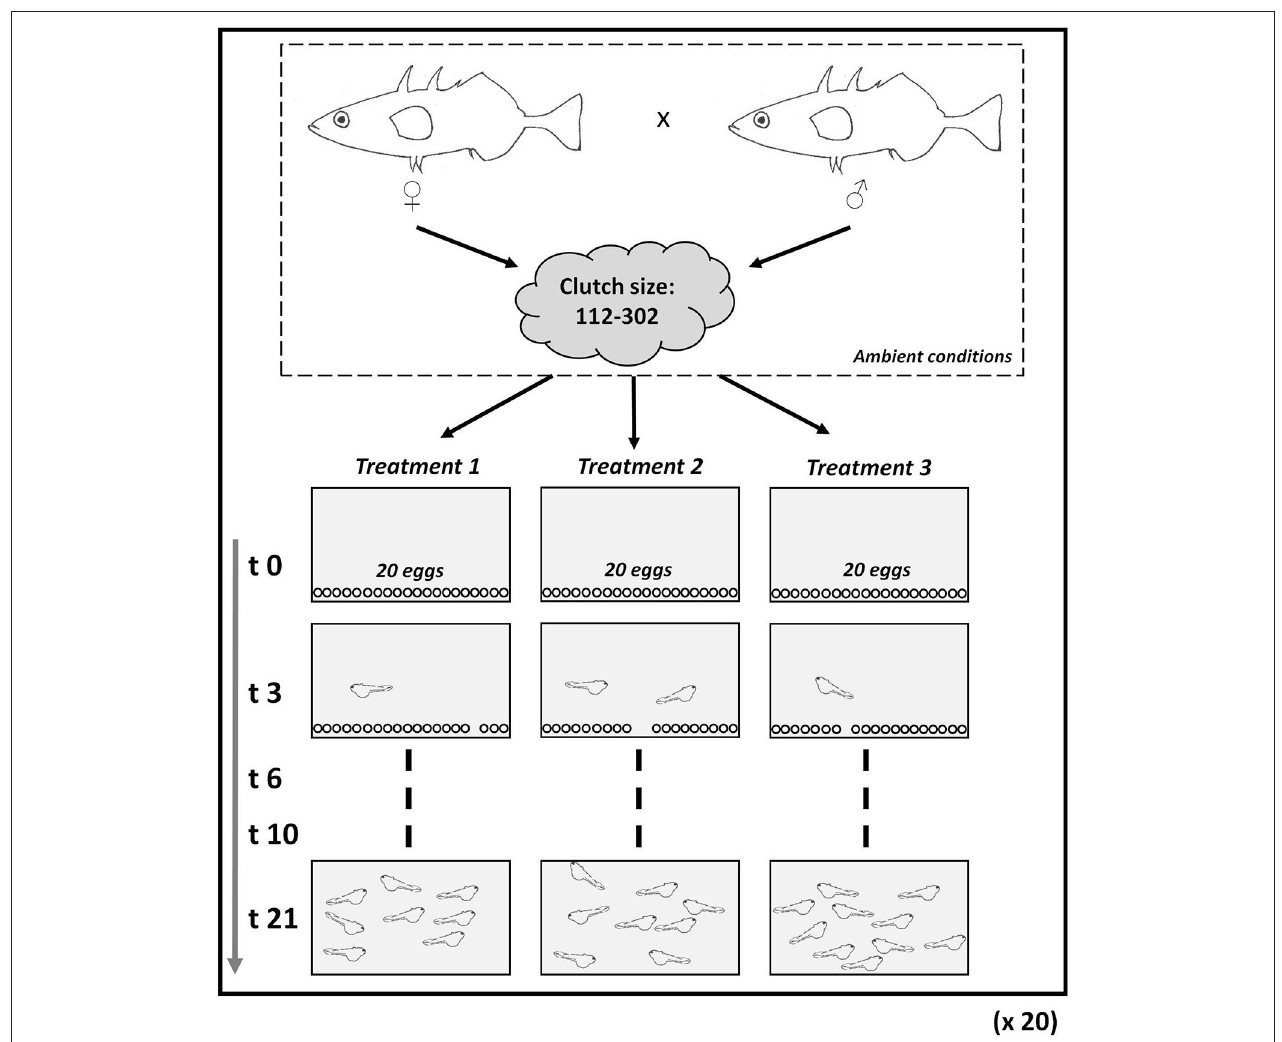
FIGURE 1 | Experimental set-up. After spawning, eggs of Gasterosteus aculeatu s were distributed into three different aquaria and exposed to ambient pH (Treatment 1, i.e., control), intermediate pH (Treatment 2), and low pH (Treatment 3). The experiment started when eggs were placed gently into the aquarium (t0) and were terminated after 3 weeks (t21). The procedure was repeated 20 times with eggs from 20 couples (18 were analyzed; see Methods).